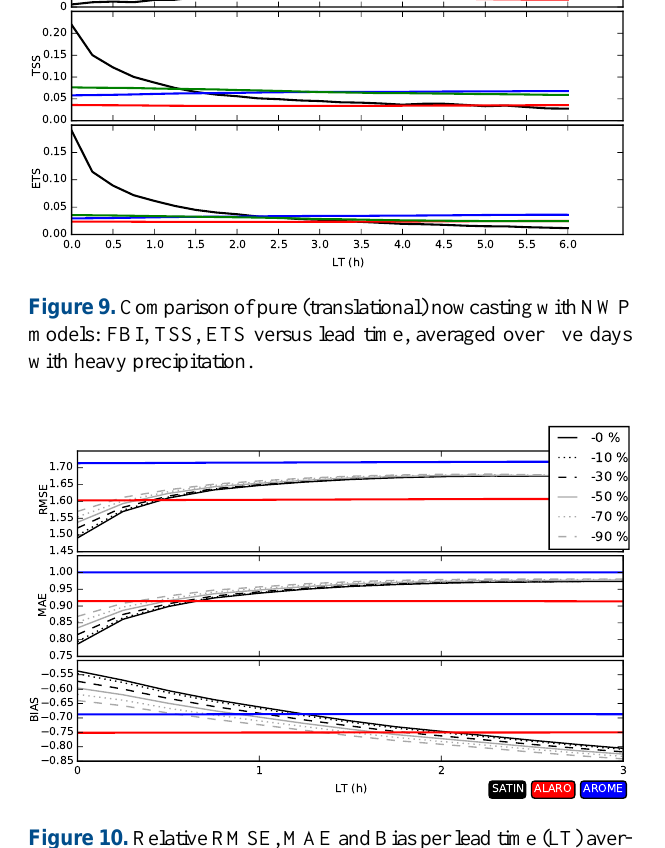
Figure 10. Relative RMSE, MAE and Bias per lead time (LT) aver- aged over July 2014. Several SATIN runs are shown with progres- sively less stations entering the algorithm. ALARO and AROME are shown as